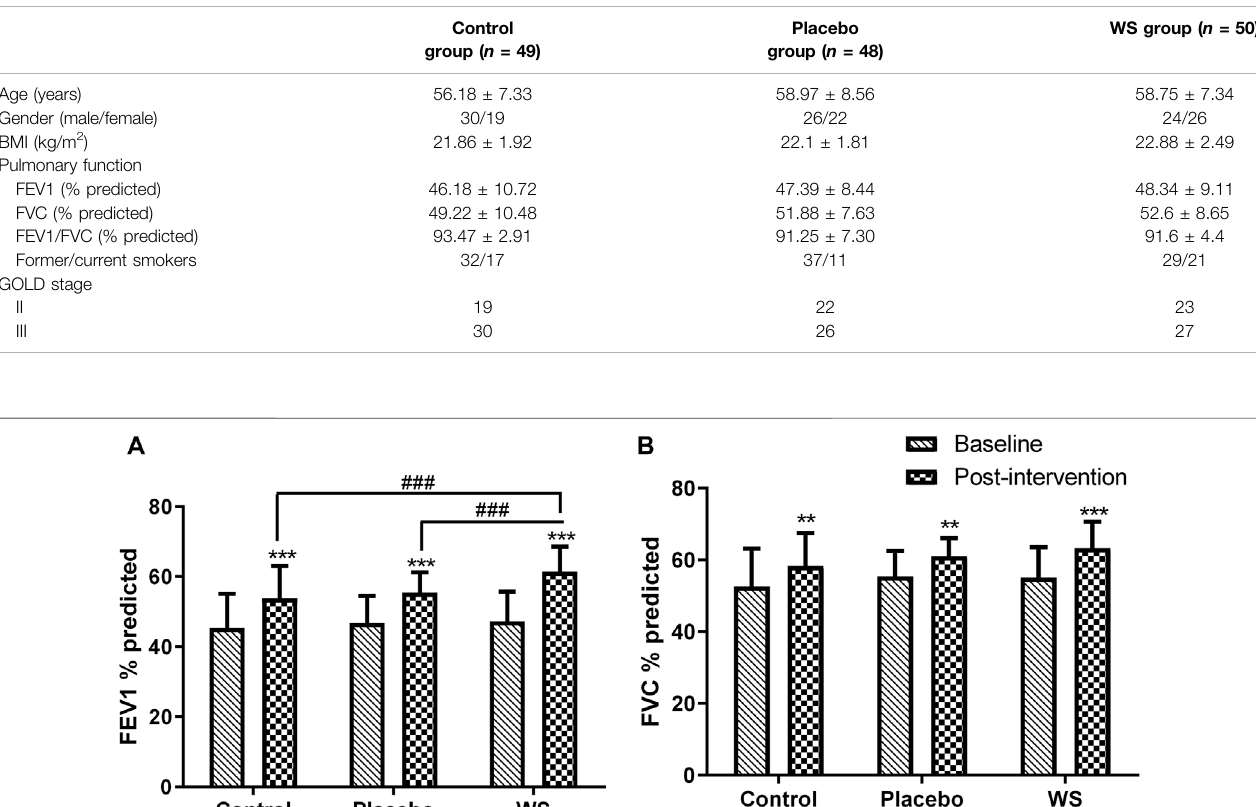
protein carbonyl content per milligram of protein. A bovine serum albumin (BSA) standard curve was developed and used to analyze the total plasma protein concentration ( Figure 5F ).